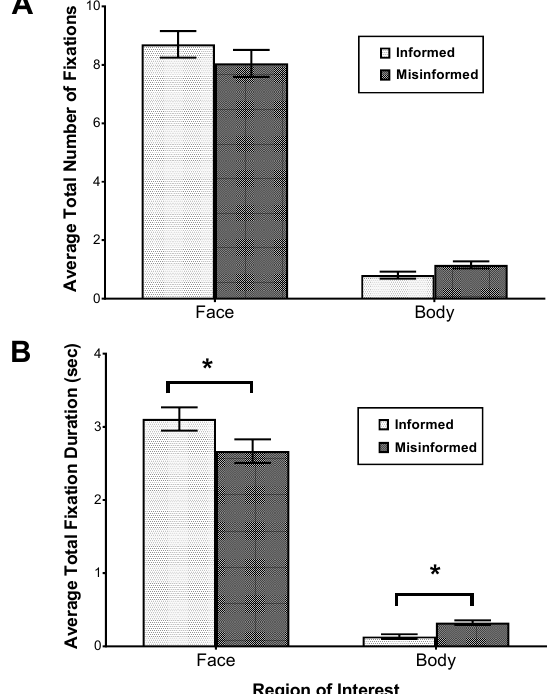
Figure 4. (A) Average total number of fixations and (B) average total fixation duration on faces and bodies as a function of awareness of eye tracking (informed vs. misin- formed group). Error bars represent standard errors of the